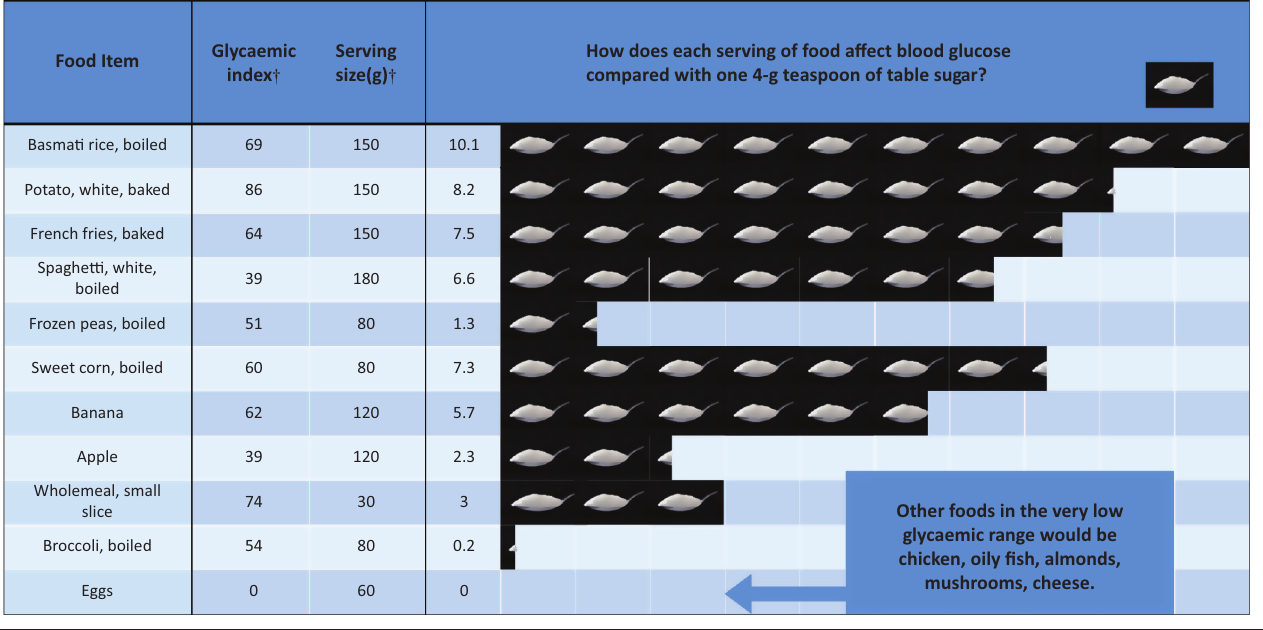
Other foods in the very low glycaemic range would be